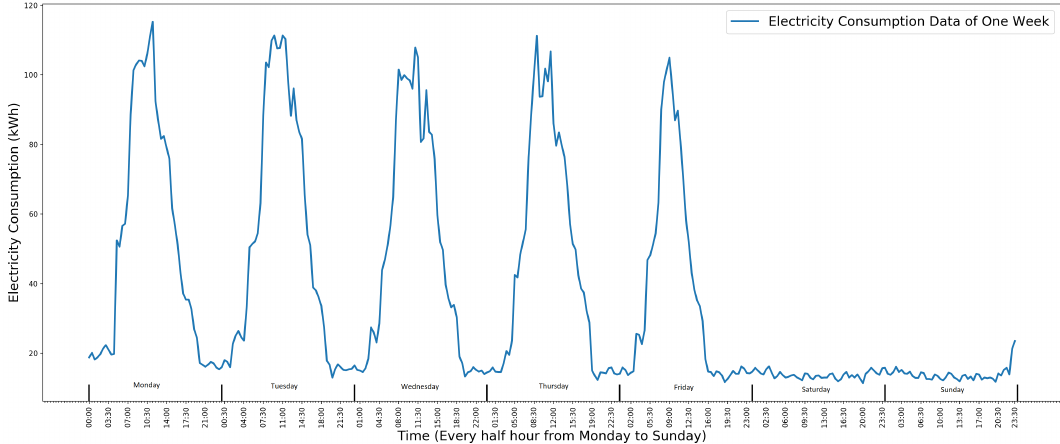
Figure 1. One week’s electricity consumption data of a school. The x -axis is the electricity consumption (kWh). The y -axis is the time. Adapted from